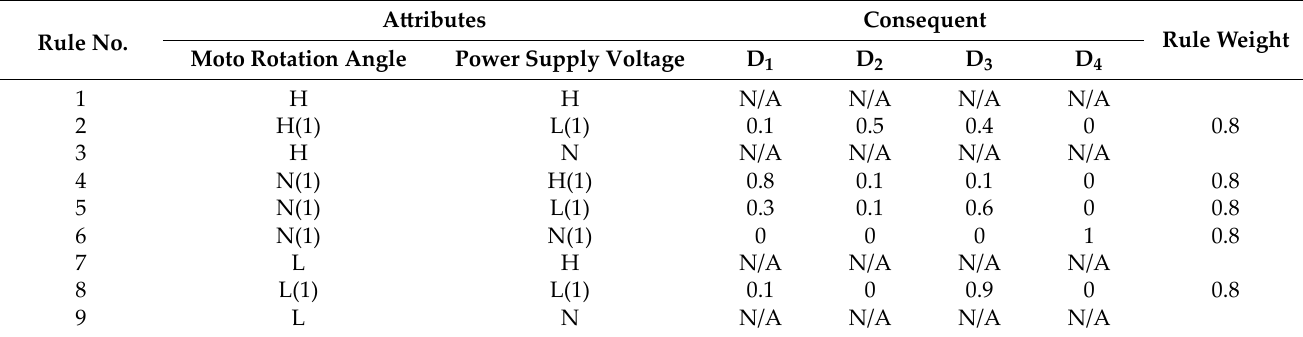
Table 11. Incomplete BRB.